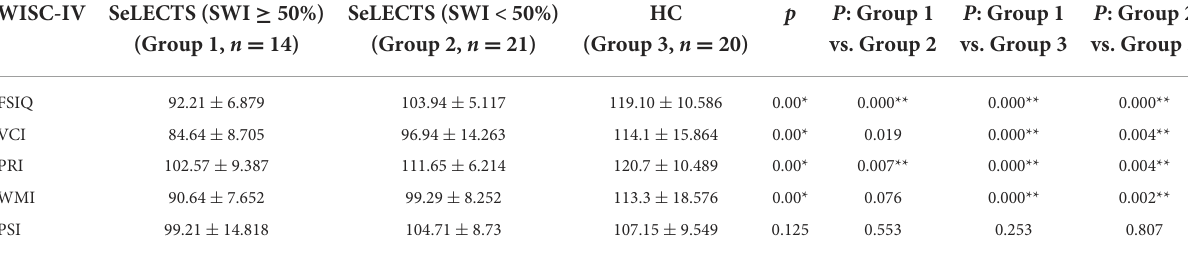
TABLE 2 Comparison of WISC-IV scores between the SeLECTS (SWI ≥ 50%), SeLECTS (SWI < 50%), and HC groups. WISC-IV SeLECTS (SWI ≥